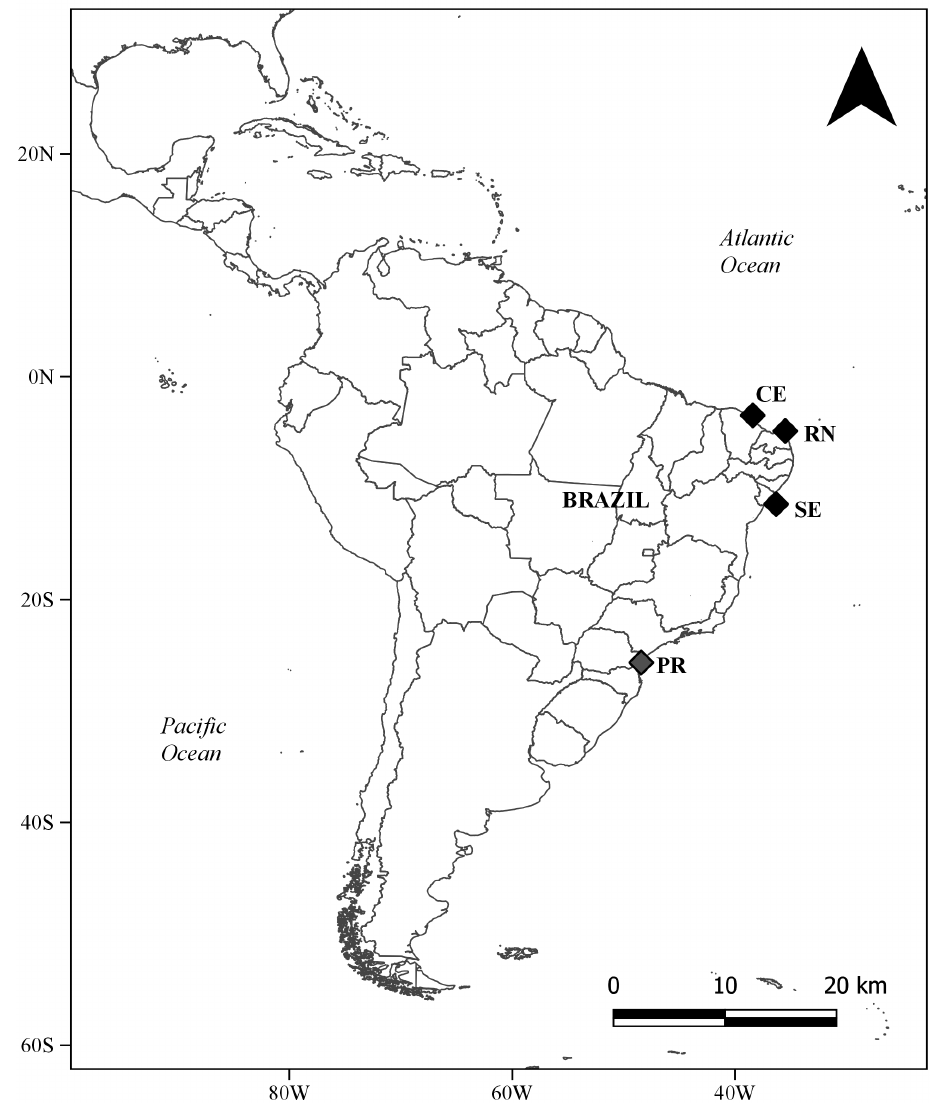
FIGURE 1 | Map displaying the locations in Southwestern Atlantic where the individuals of the Blacktip Shark, Carcharhinus limbatus , were sampled. Black squares: present study; gray square: Bornatowski (2008). Abbreviations: CE, Ceará; RN, Rio Grande do Norte; SE, Sergipe; PR,